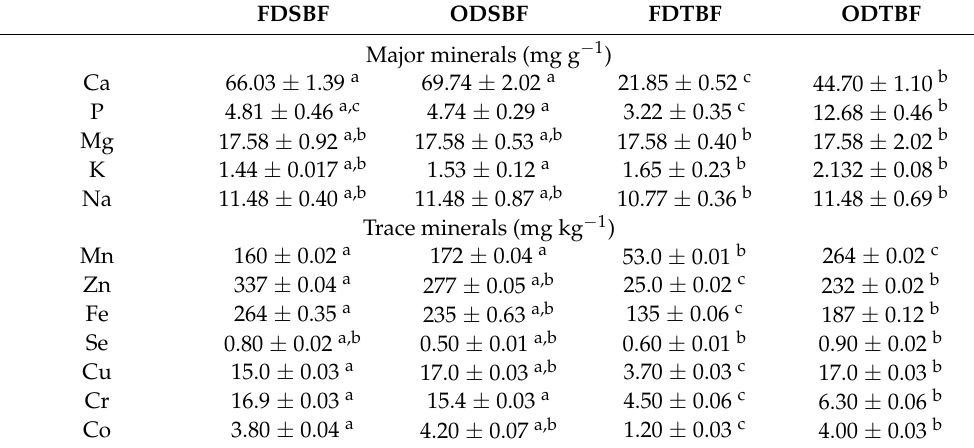
Table 3. T -test results (multiple comparisons) of mineral concentration of biofloc (in dry matter) from two waste sources (shrimp and tilapia) and two methods of drying (freeze-drying and oven drying). FDSBF